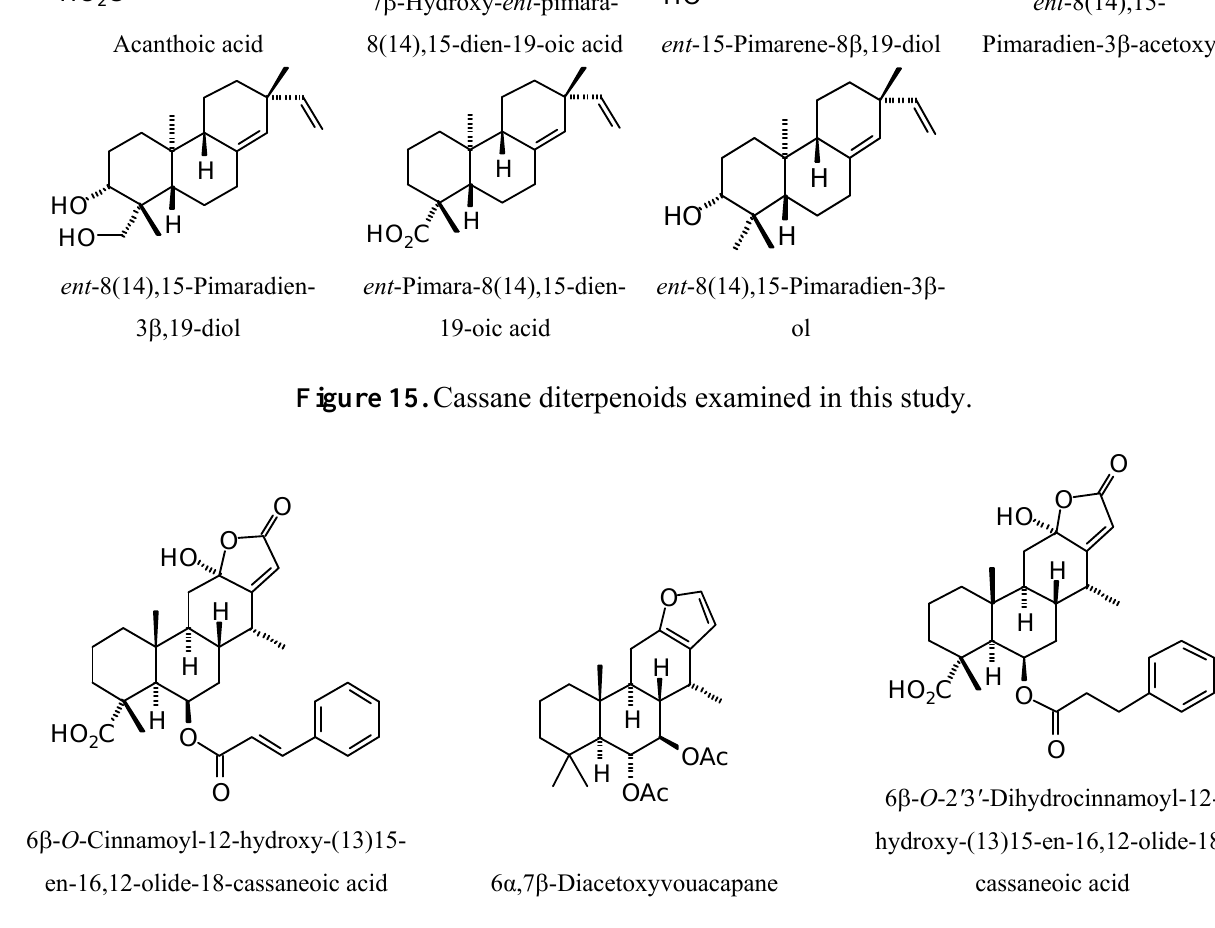
Figure 16. Icetaxane diterpenoids examined in this